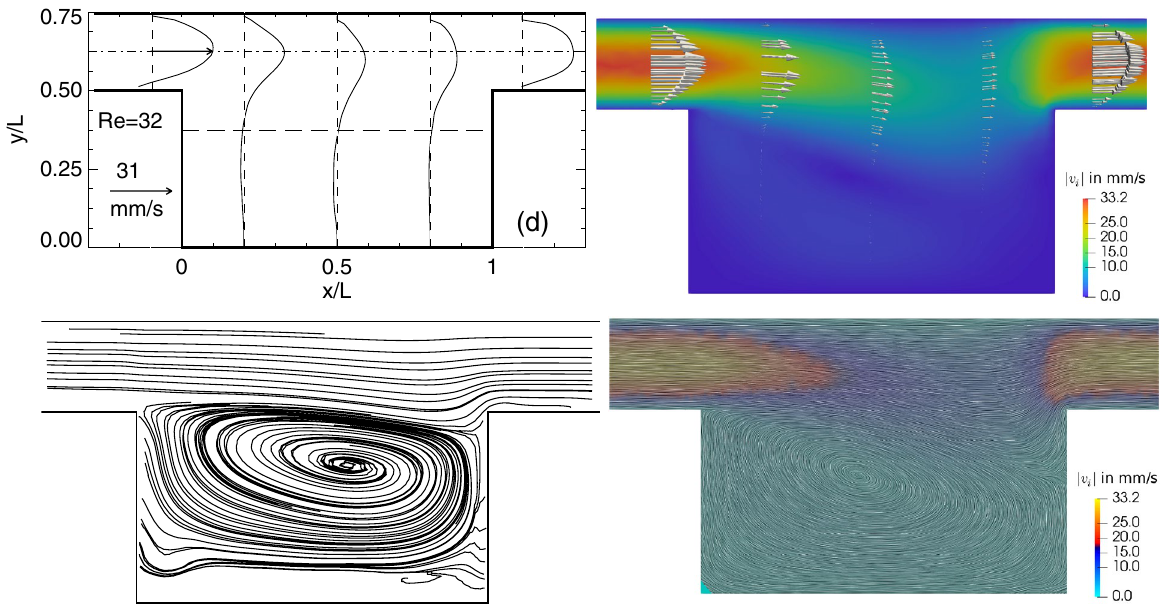
Fig. 9 Comparison of measurement and calculations: Case (d) PIV left column and CFD right column. Selected velocity profiles (top row) and streamlines (bottom row) are presented